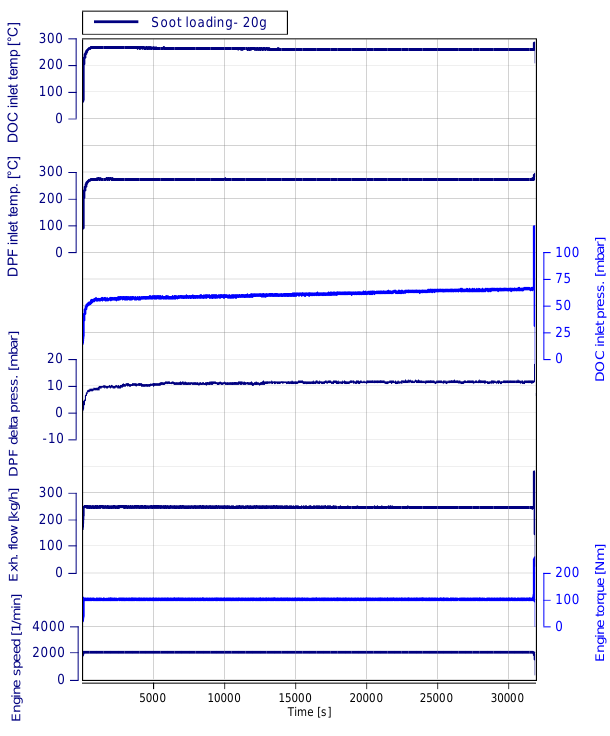
Fig. 11. Filter loading phase for passive regeneration